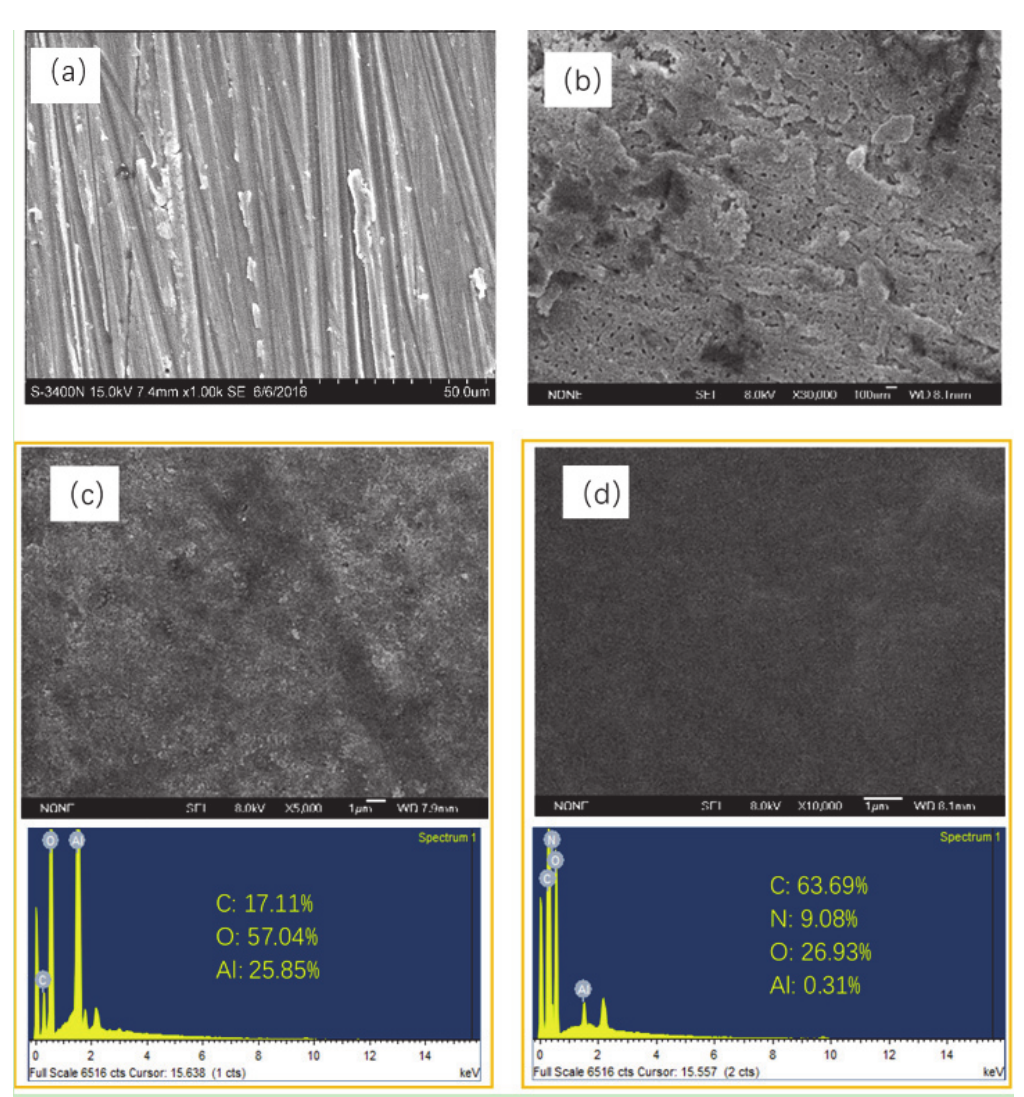
Figure 2. SEM images and energy dispersive X-ray spectrum (EDS) results of ( a ) bare Al alloy, ( b ) anodic oxide film, ( c ) sol–gel film, and ( d ) layer-by-layer (LBL) film.